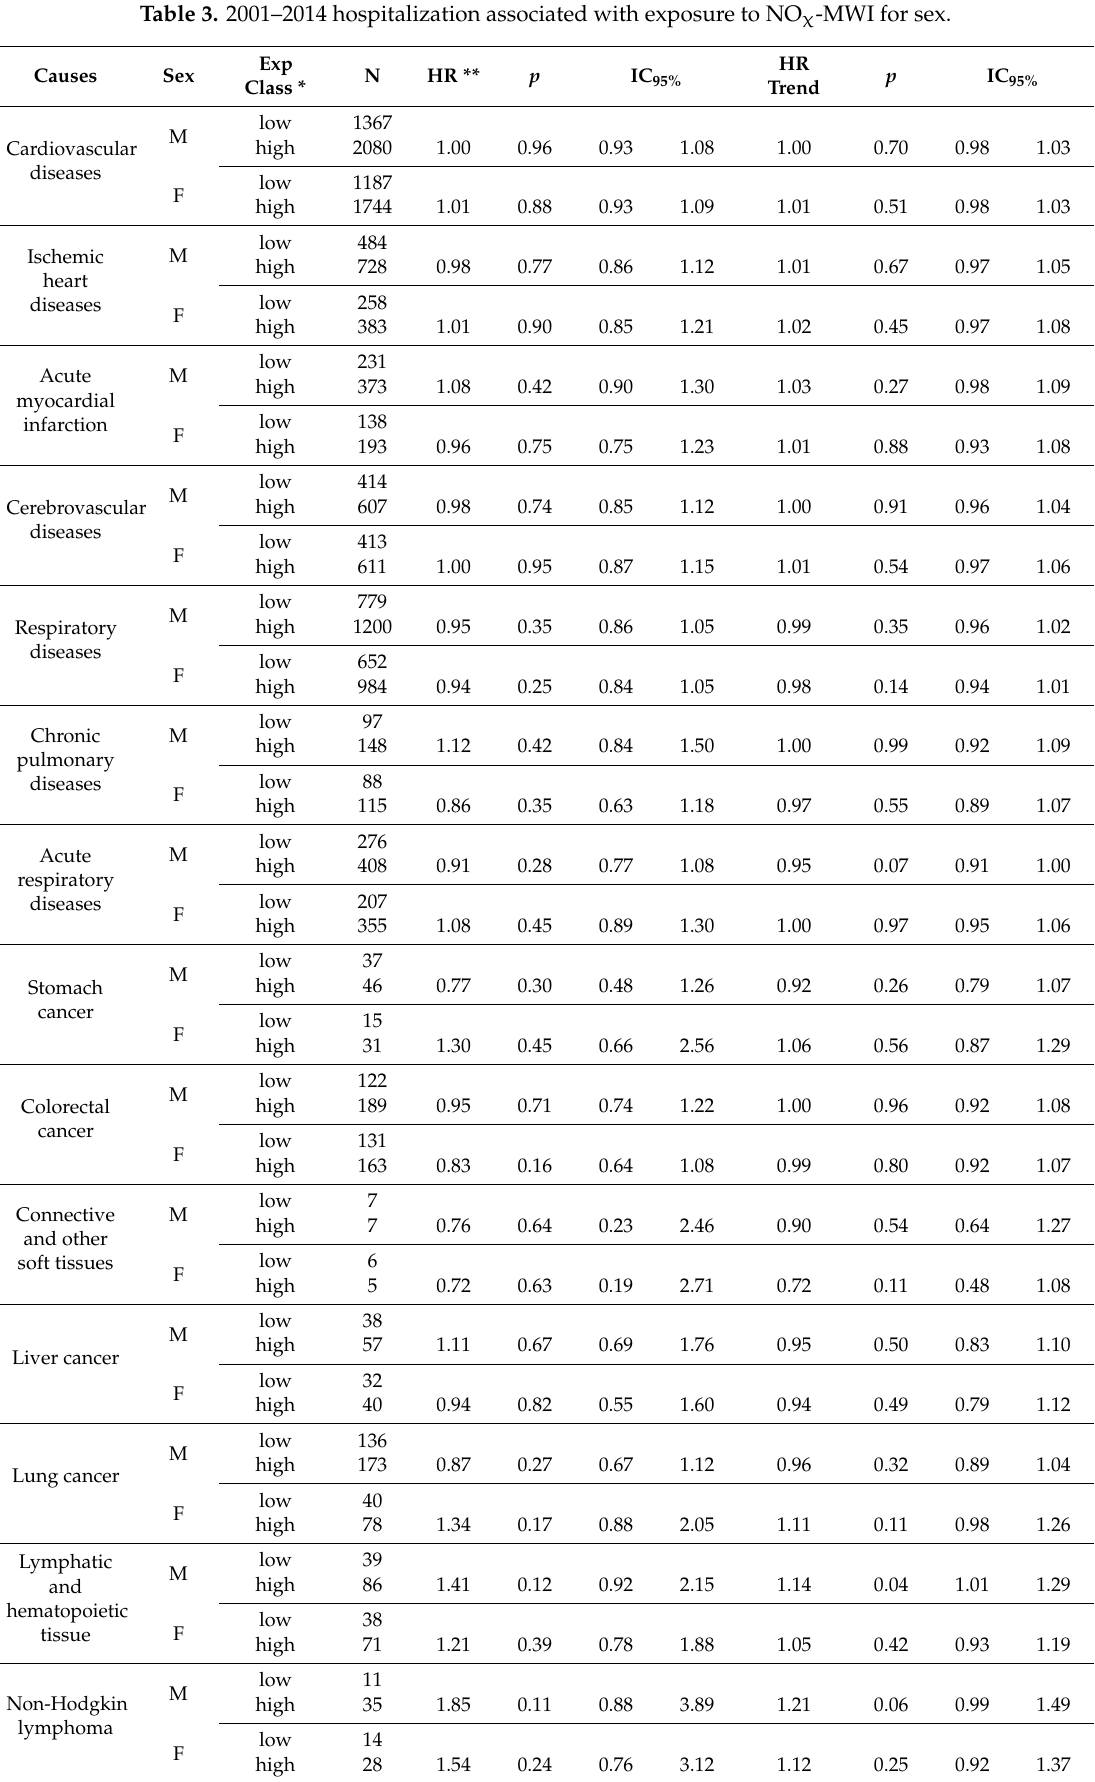
Table 3. 2001–2014 hospitalization associated with exposure to NO χ -MWI for